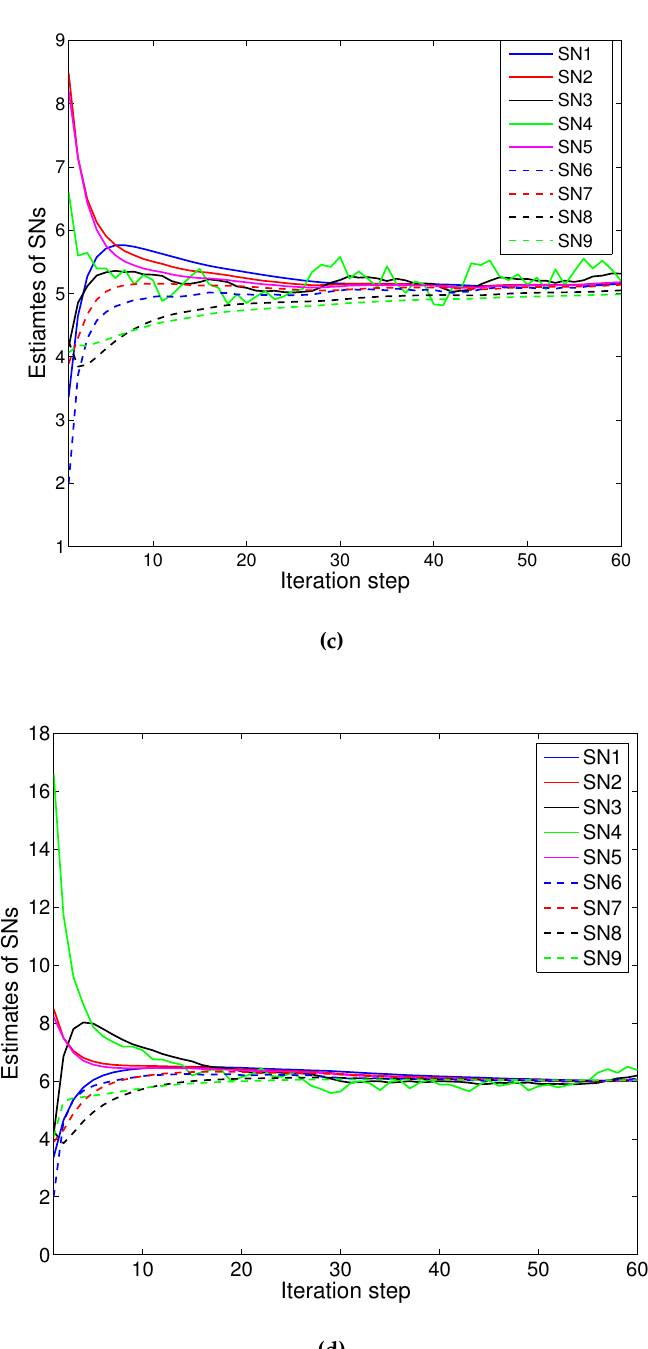
Figure 3. Convergence of the Olfati algorithm: ( a ) without attackers; ( b ) with one SDF attacker; ( c ) with one IDF attacker; ( d ) with one RDF